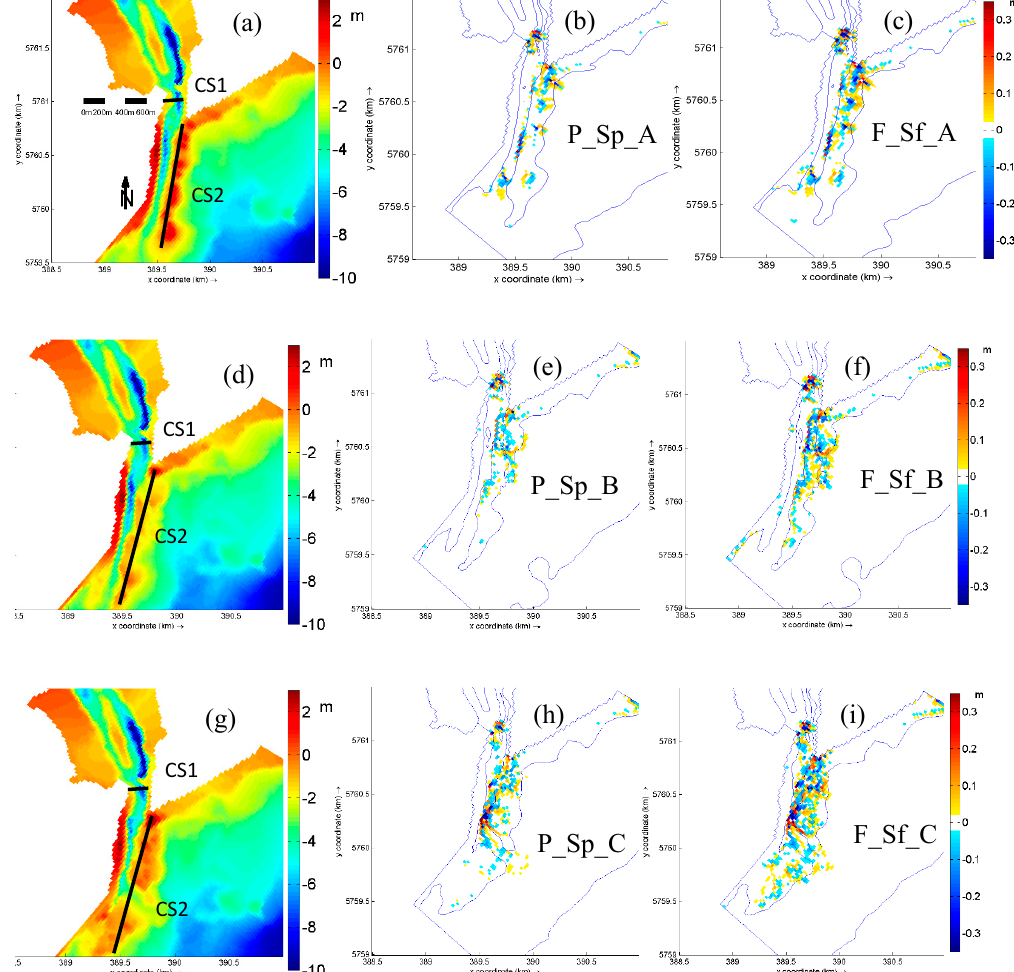
Figure 13. The bed level changes under di ff erent scenarios (Table 3) based on three di ff erent morphological states (Top: State A; Middle: State B; Bottom: State C). ( a ) initial bathymetry of State A; ( b ) bed level changes under P_Sp_A scenario; ( c ) bed level changes under F_Sf_A scenario; ( d ) initial bathymetry of State B; ( e ) bed level changes under P_Sp_B scenario; ( f ) bed level changes under F_Sf_B scenario; ( g ) initial bathymetry of State C; ( h ) bed level changes under P_Sp_C scenario; ( i ) bed level changes under F_Sf_C scenario. The black lines in the left figures are the selected cross sections. All the named scenarios are referred to Table